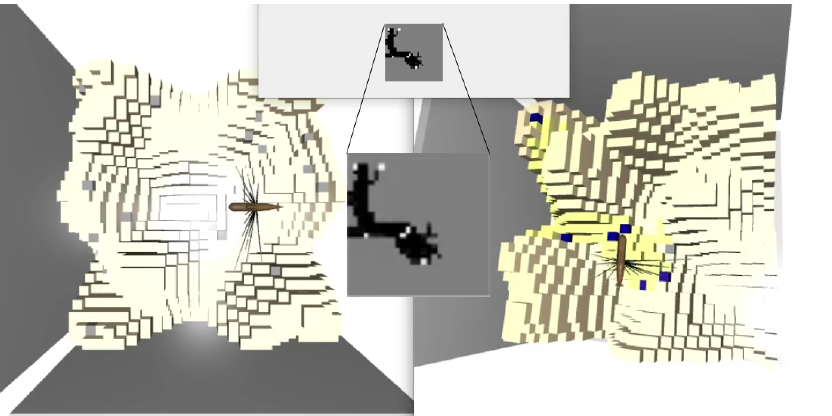
Figure 1. Left side: The ground truth map, where the gray areas are litter. Right side: Map discovered by the agent. A yellow color of the voxels means there is a strong probability for no litter, and blue means a high probability of litter. Top and center: 2D projection of the currently discovered map, where white represents litter, and black is no litter.